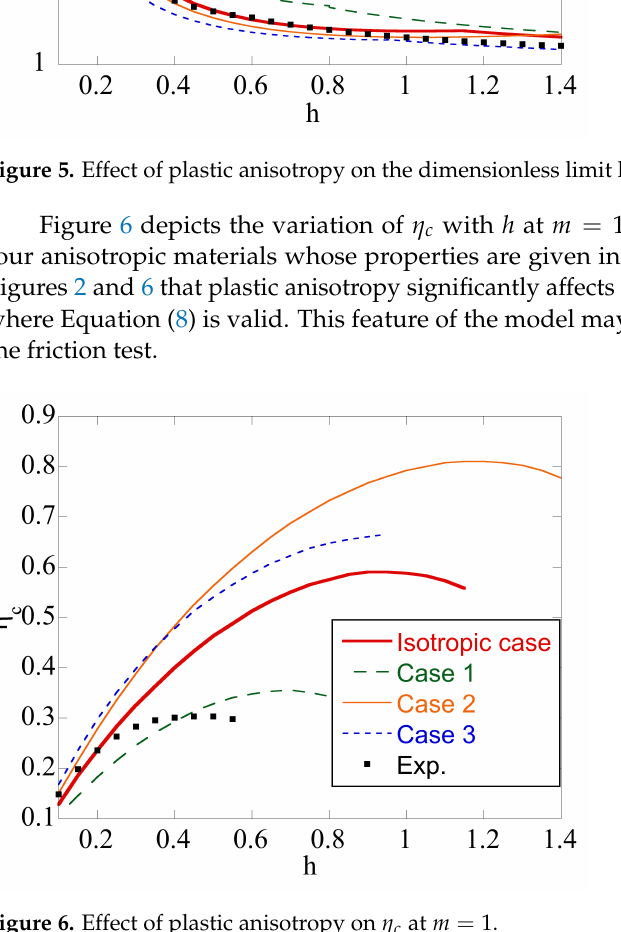
Figure 6. Effect of plastic anisotropy on η c at m =